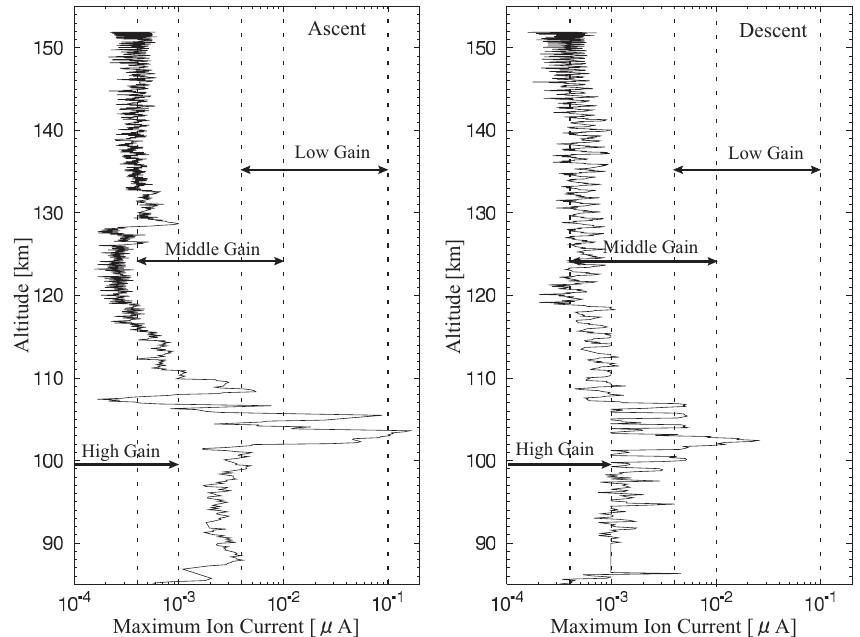
Fig. 4. Height profile of the ion current from the v-i characteristic curve for the up leg (left) and the down leg (right) of the rocket trajectory. Three amplifiers of different gains (low, middle, and high) provide the height profile of the ion current. The rocket spinning causes fine scale fluctuation in the current. The large structure, which appears in the 100–112km and 127–130km during up leg, shows the real structure of the ionosphere, although down leg profile is highly modulated by rocket spin, a small reduction in the current, which exists at the height of 118–122km and the peak of the ion current at the height of 100–106km, seems to be real.